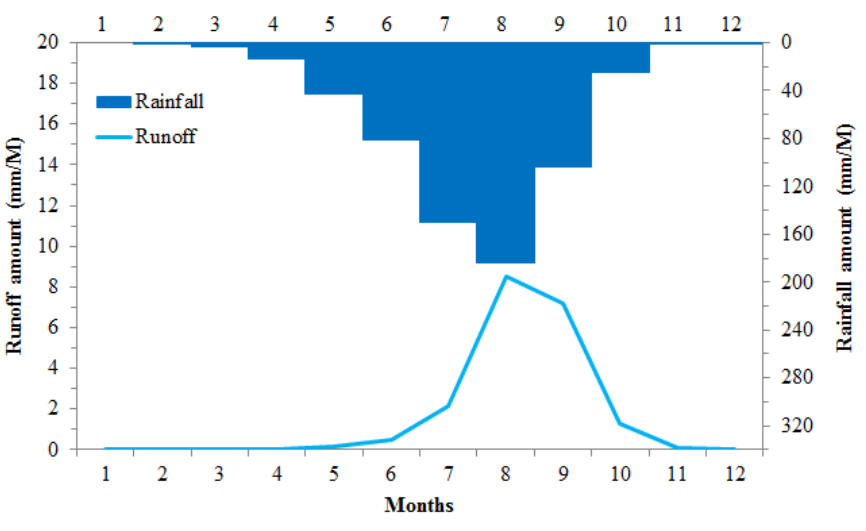
Figure 2. Mean hydrological regime of the upstream watershed of Wayen during the 1978–1999